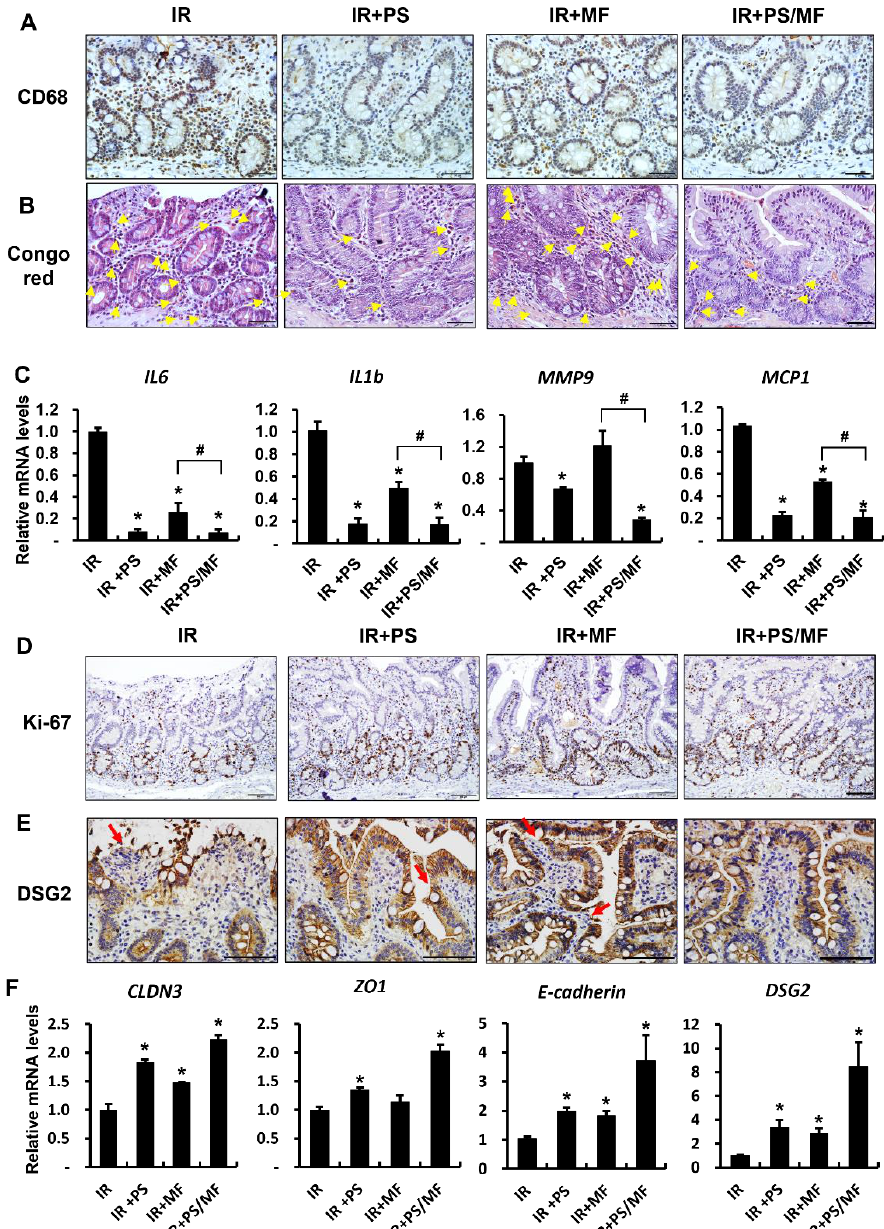
Figure 6. Effect of combined pravastatin and metformin treatment on inflammatory response and epithelial integrity in irradiated minipig model. ( A ) Immunohistochemical analysis of CD68 and ( B ) congo red stain in small intestine of irradiated (IR), pravastatin-treated IR (IR + PS), metformin- treated IR (IR + MF), combined PS and MF-treated IR (IR + PS/MF) minipigs. Yellow arrows indicate eosinophils. Bar = 50 µ m. ( C ) mRNA levels of inflammatory cytokines, such as interleukin (IL) 6, IL1b, matrix metallopeptidase 9 (MMP9), and monocyte chemoattractant protein 1 (MCP1) in the small intestine of IR, IR+PS, IR+MF, IR+PS/MF groups. Immunostaining of ( D ) Ki-67 and ( E ) desmoglein 2 (DSG2) in the small intestine. Red arrows indicate defective DSG2 expression in the epithelium. Bar = 100 μm. ( F ) mRNA levels of intercellular junction molecules, such as claudin 3 (CLDN3), zonula occludens 1 (ZO1), E-cadherin, and DSG2 in the small intestine of IR, IR + PS, IR+MF, IR+PS/MF groups. Data are presented as the mean ± standard error of the mean; n = 4 per group. * p < 0.05 compared to the IR group; # p < 0.05 compared to the IR + MF group.